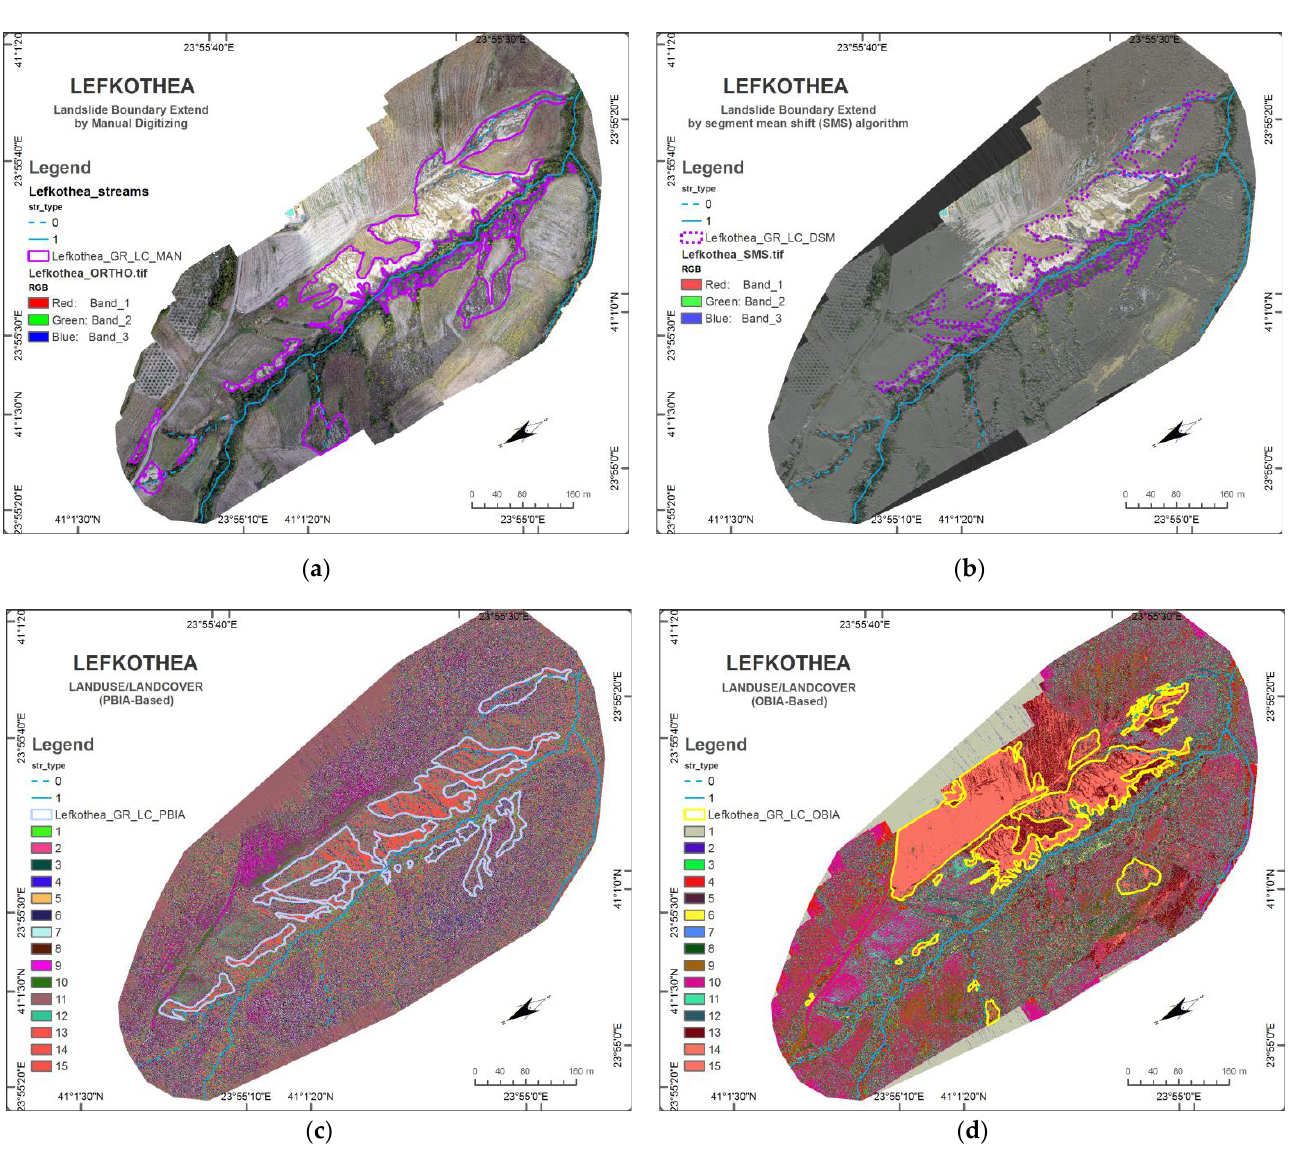
Figure 9. The results concerning Lefkothea’s torrent in Greece captured by the drone flight on 1 September 2021: ( a ) boundaries of affected area, manually digitized; ( b ) segment mean shift (SMS) algorithm; ( c ) ISO Cluster unsupervised classification (based on the orthomosaic), and ( d ) ISO Cluster unsupervised classification (based on the SMS). Table 3. The statistics produced by each method for the Greek